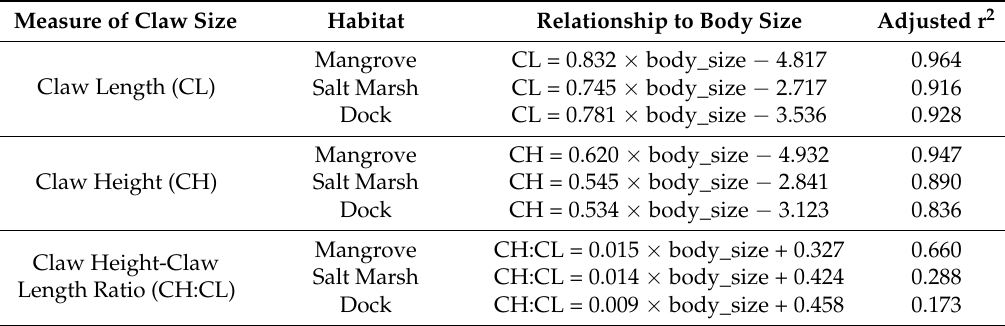
Table 3. Relationships between crab body size and each measure or claw size in each